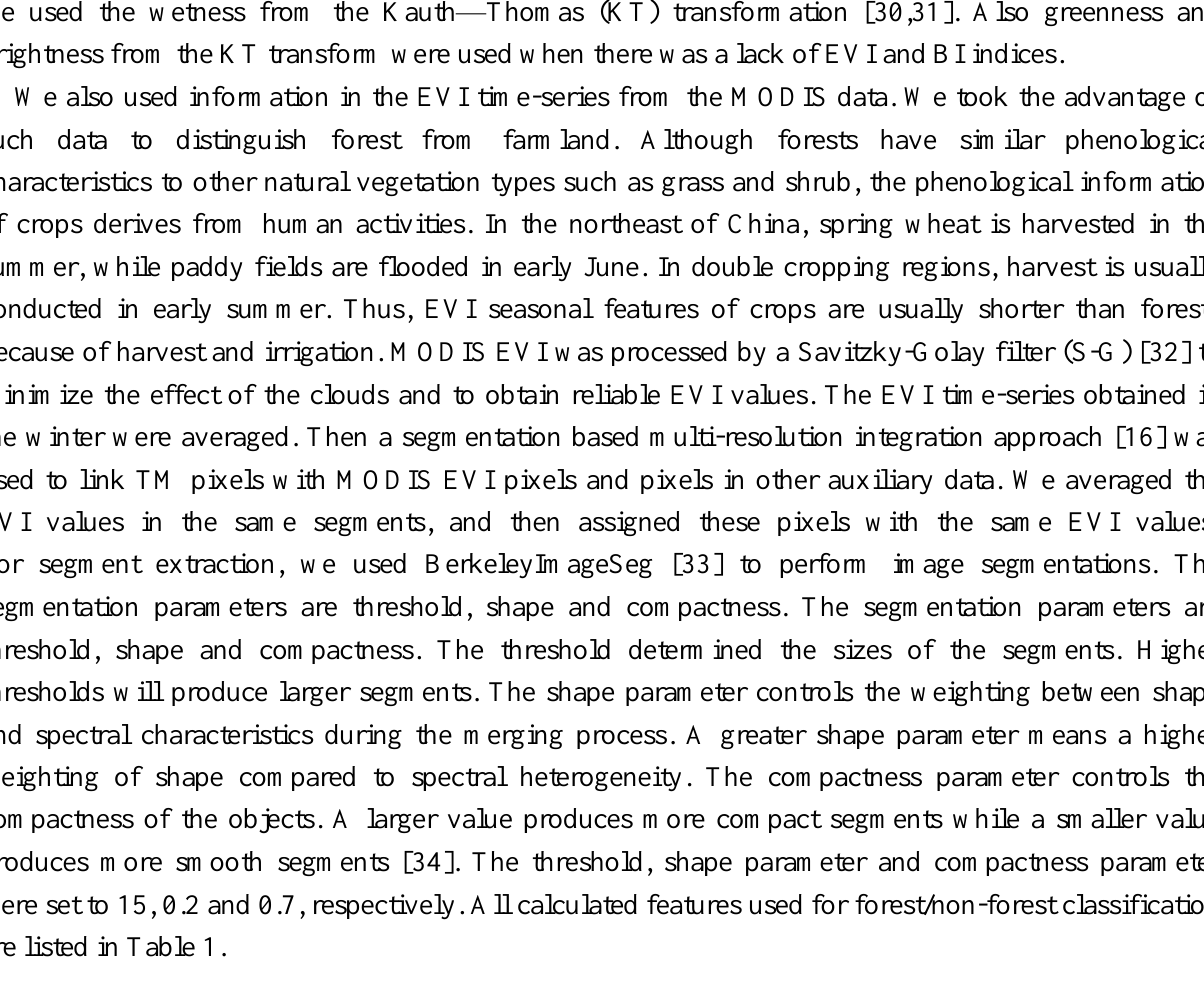
Table 1. List of input features for forest/non-forest